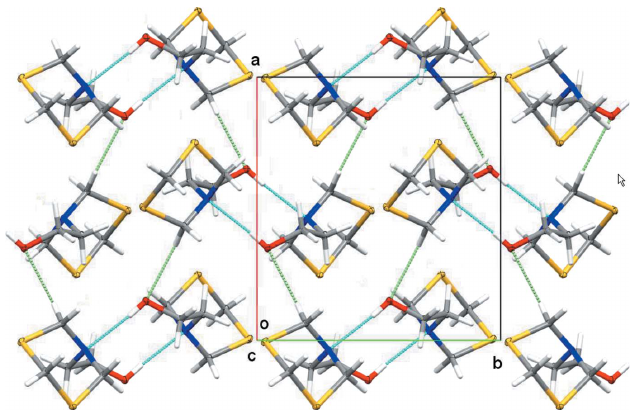
Figure 7 Partial packing view and hydrogen bonding in the form II polymorph, viewed down the c axis. Turquoise dashed lines: O—H (cid:2)(cid:2)(cid:2) N hydrogen bonds. Light-green dashed lines: C—H (cid:2)(cid:2)(cid:2) O interactions. Displacement ellipsoids are shown at the 50% probability